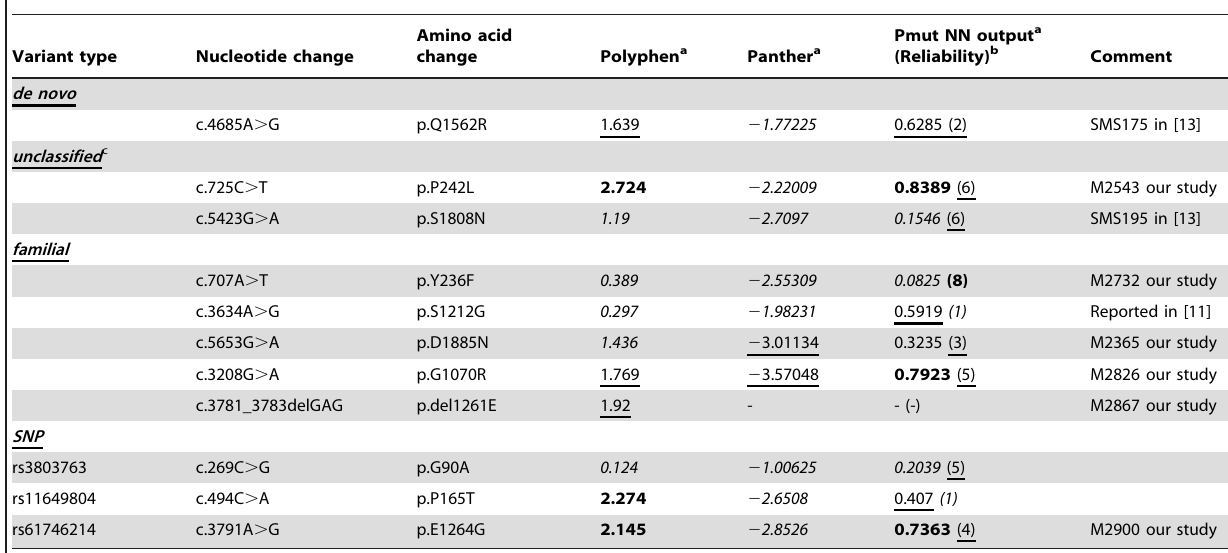
Table 2. Severity predictions of missense